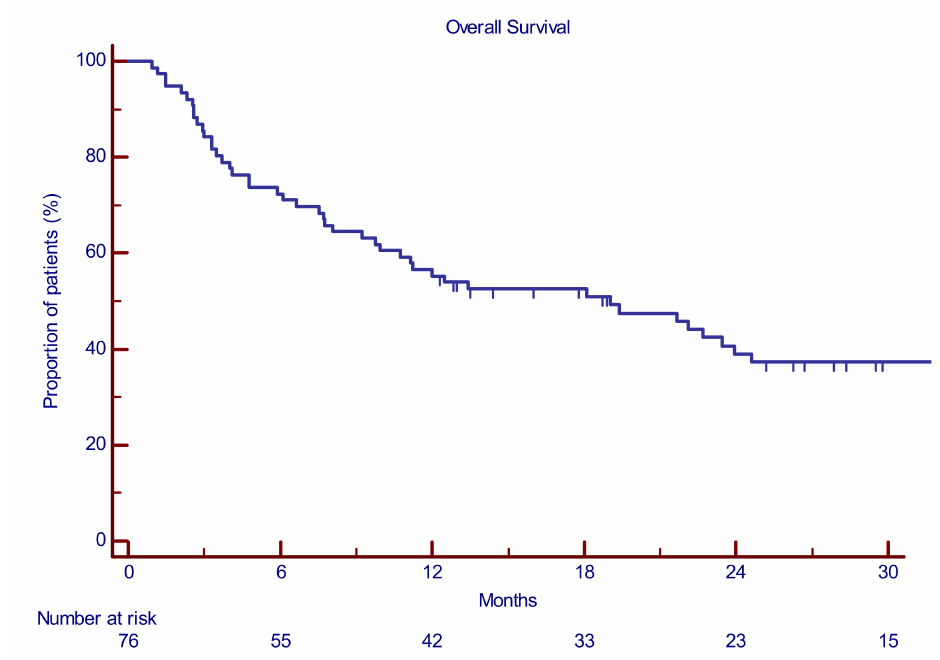
Figure 1. E ffi cacy of PomaD in